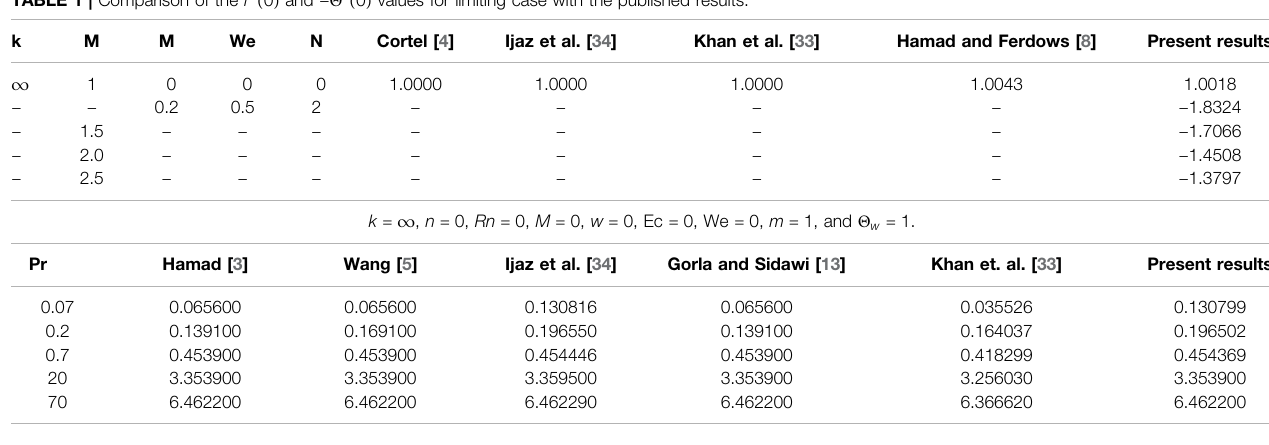
TABLE 1 | Comparison of the f ′ ( 0 ) and − Θ ′ ( 0 ) values for limiting case with the published